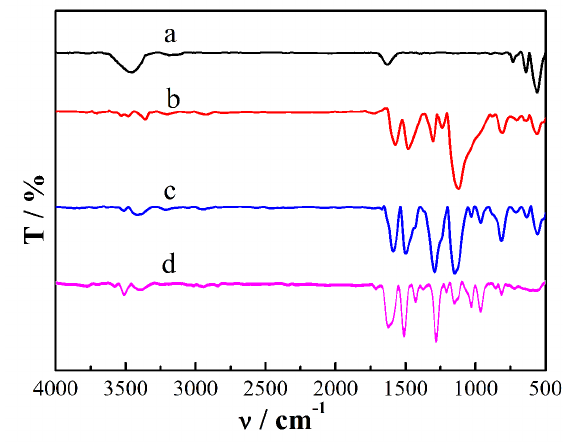
Figure 2. IR spectra of samples: a, γ-Fe 2 O 3 ; b, γ-Fe 2 O 3 /PANI; c, γ-Fe 2 O 3 /PANI-curcumin; and d, curcumin.